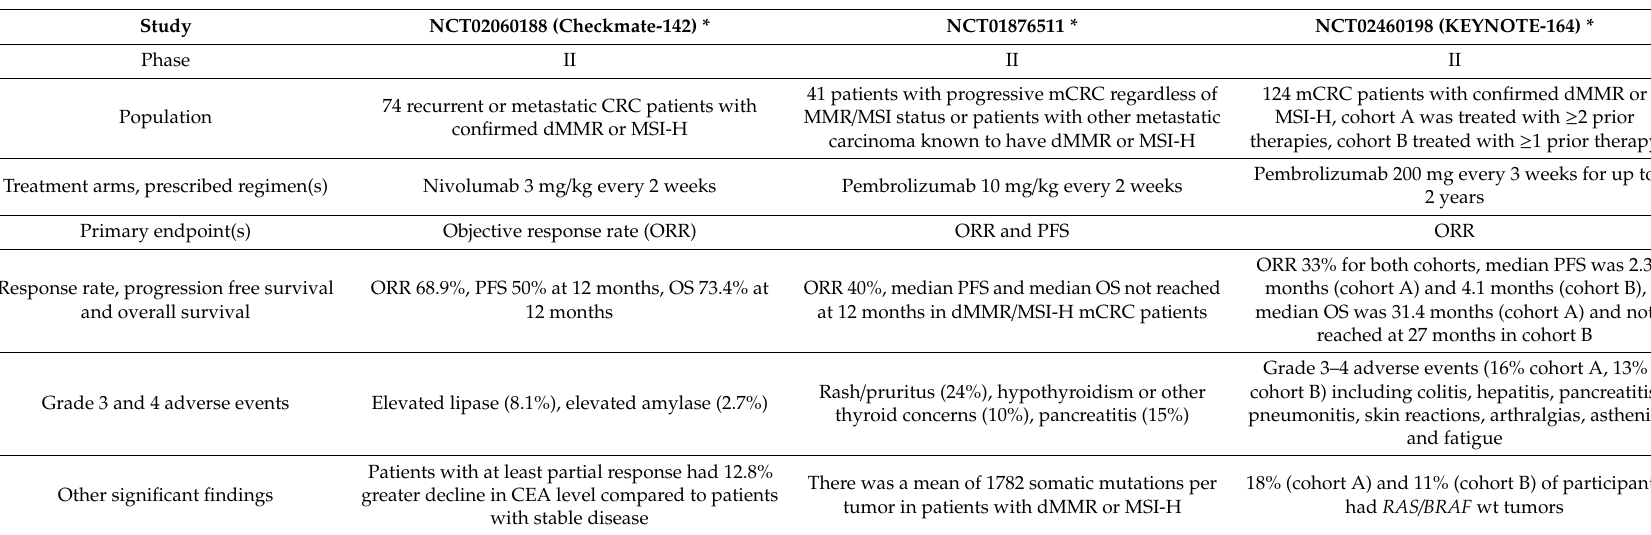
Table 2. Recent trials involving checkpoint inhibitors in metastatic colorectal cancer (mCRC)